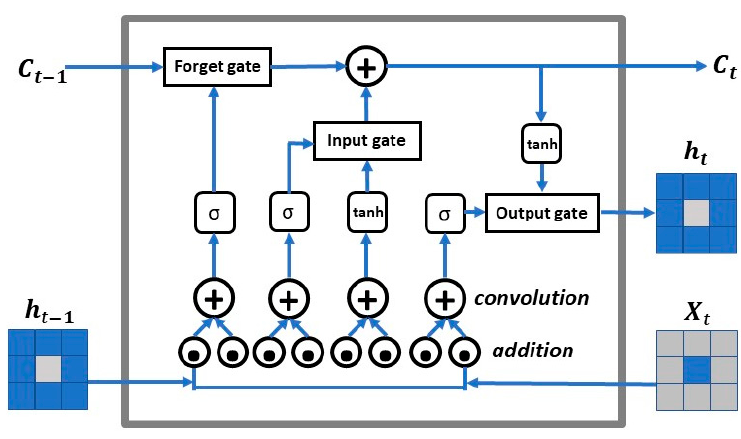
Figure 7. The inner structure of an example ConvLSTM cell.